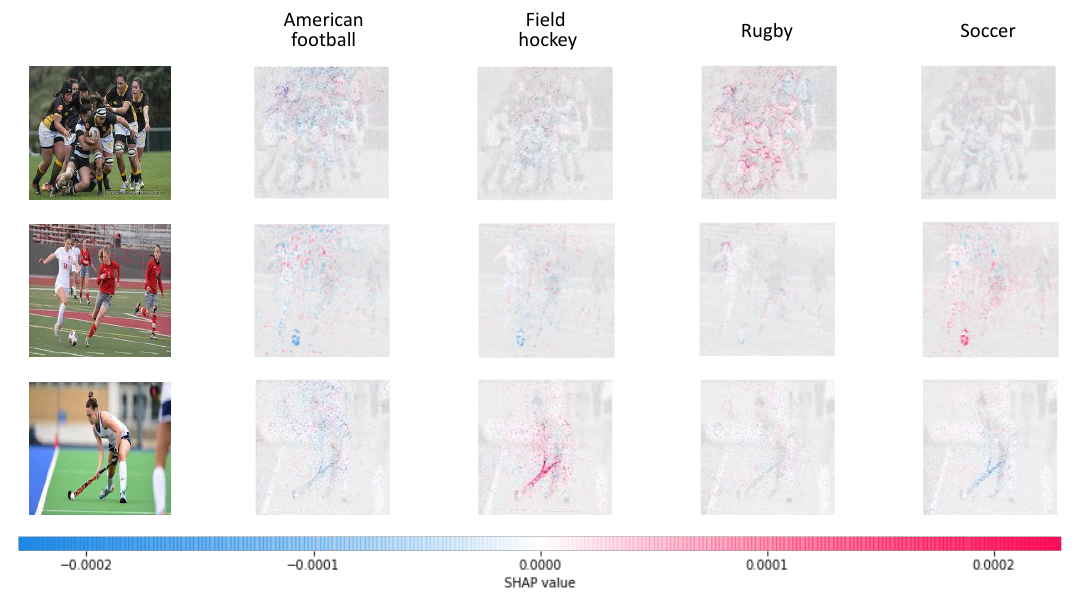
Figure 11. Examples of SHAP explanations: red pixels indicate parts of image with a positive impact towards specific sport, while blue pixels indicate parts with a negative impact. In the top row, we can see how the packed formation of athletes contributed towards recognizing rugby. In the middle row, the soccer ball was decisive. In the bottom row, the hockey stick was the most informative feature for identifying field